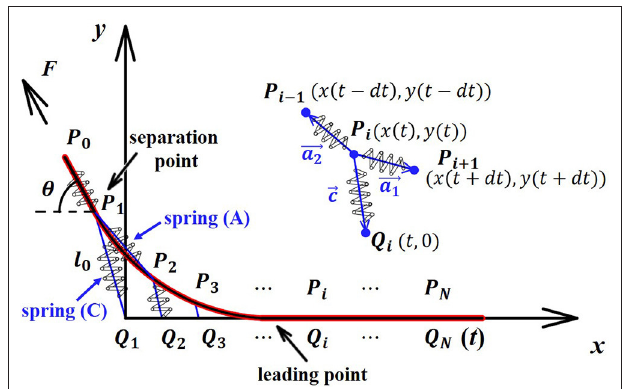
FIGURE 2 | Schematic of the spring contact tape